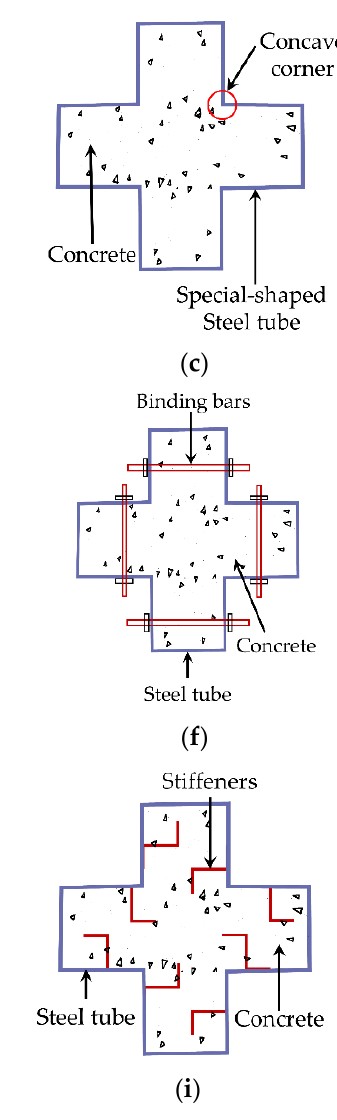
Figure 1. SS-CFSST composite columns ( a ) traditional L-shaped; ( b ) traditional T-shaped; ( c ) tradi- tional cross-shaped; ( d ) L-shaped with binding bars; ( e ) T-shaped with binding bars; ( f ) cross- shaped with binding bars; ( g ) L-shaped with stiffeners; ( h ) T-shaped with stiffeners; ( i ) cross-shaped with stiffeners.